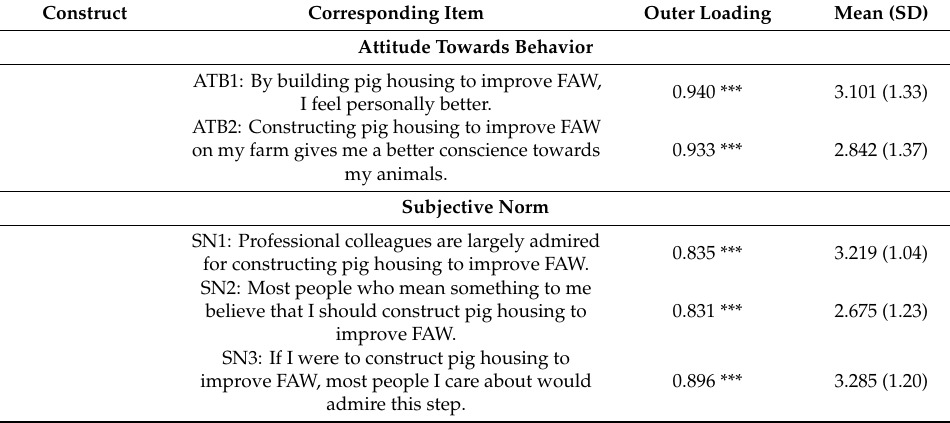
Table A2. Descriptive results for the applied indicators and outer model